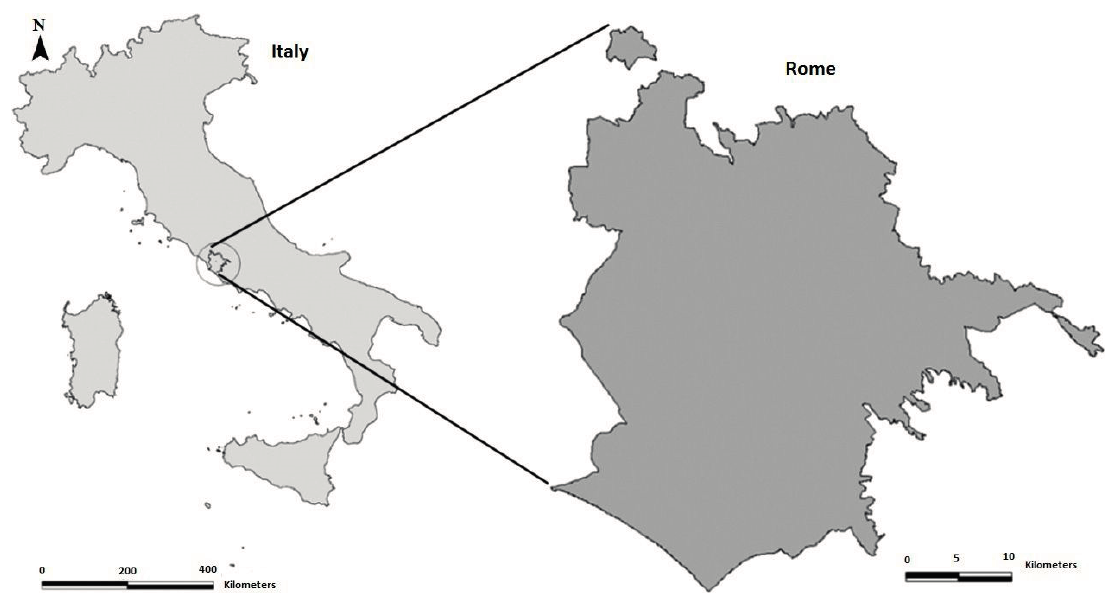
Figure 2. Study area: Rome. Source: Adapted from